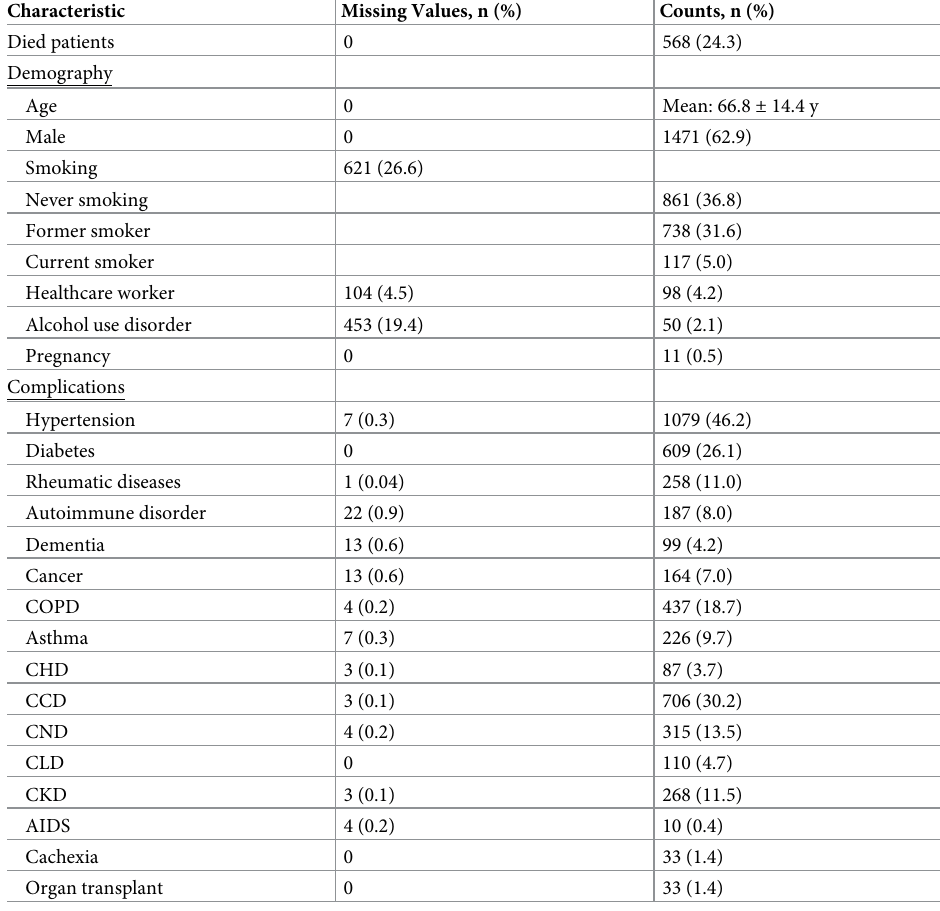
Table 1. Participant characteristics with missing values of COVID-19 patients (training